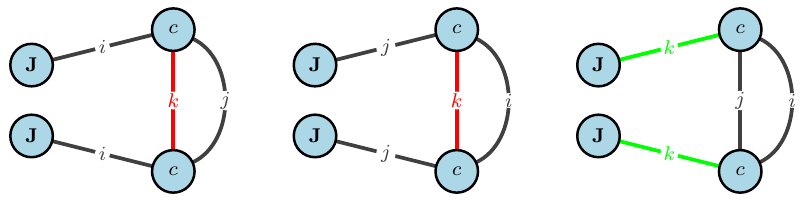
Figure 3 . Theta-J diagram. The first two on the left give same value due to the symmetry of i, j pairings. In the instance on the right, since we use the k index in pairing the two copies of J to c , then one factor of g from c k → c ijk is cancelled by the g − 1 factor from G IJ , thus giving an identity ij pairing between J and c , and hence the color green.